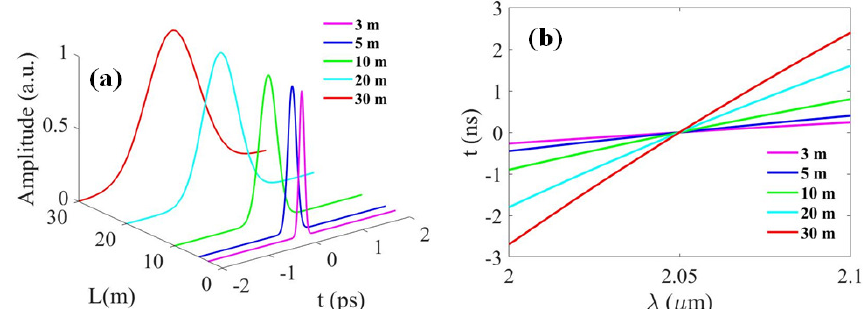
Figure 8. Conceptual description of the wavelength-to-time mapping procedure: ( a ) The optical pulse propagates along the prism pair in time and space domains, where the temporal profile of the optical ) ; and ( b ) time-to-wavelength mapping. The purple √ pulse is described by A = exp ( − τ 2 2 ( ∆ τ / ( 2 2 In 2 )) 2 line, blue line, green line, cyan line, and red line represent a propagation distance L of 3 m, 5 m, 10 m, 20 m, and 30 m, respectively. The initial pulse width and spectrum bandwidth are 0.01 ps and 100 nm, respectively, and the propagation angle is 0.5 ◦